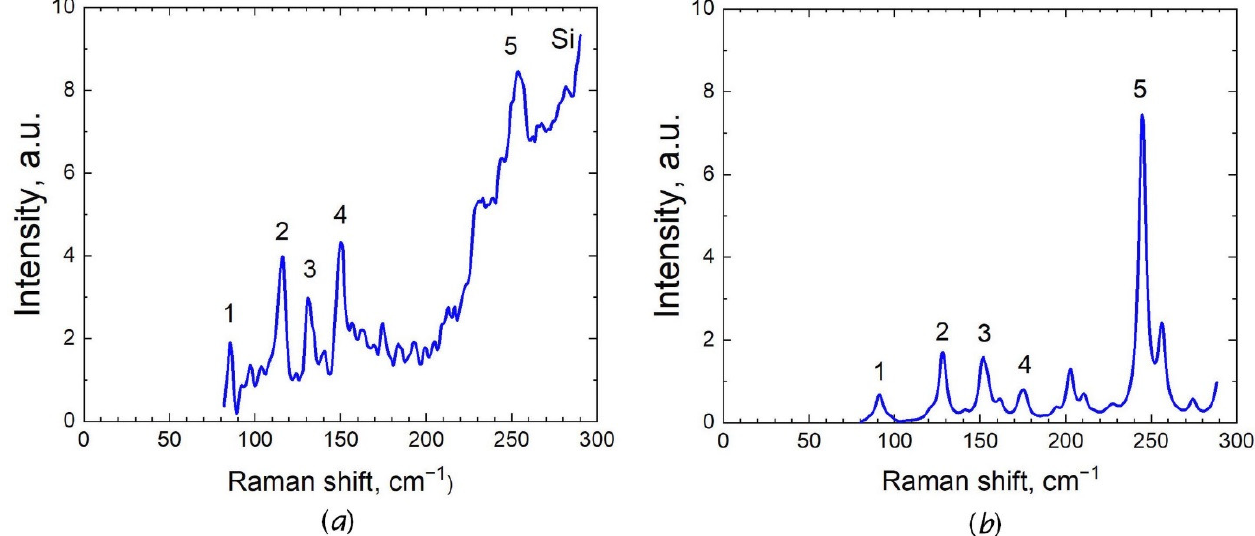
Figure 10. The Raman spectrum of the 𝜀 -Ga 2 O 3 /SiC/Si sample in confocal geometry excluding birefringence ( a ). The theoretical Raman spectrum of ε -Ga 2 O 3 calculated by the DFT method in the range up to 300 𝑐𝑚 (cid:2879)(cid:2869) , excluding birefringence ( b ). The five highest lines of the spectrum are numerated and correspond to the following frequencies: 86, 117, 131, 150, and 253 cm (cid:2879)(cid:2869) . In order to find out the nature of oscillations